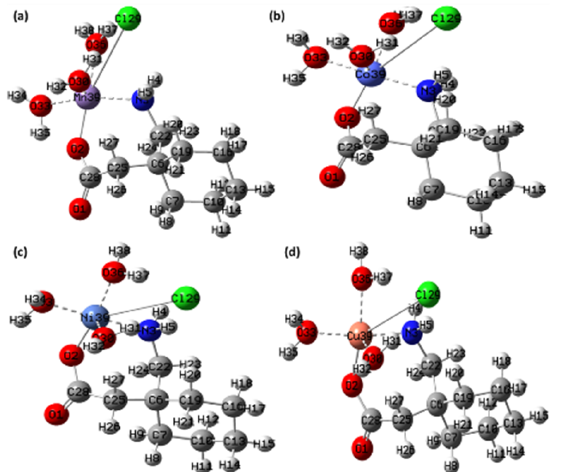
Figure 16. The optimized structure of the synthesized metal complexes ( a ) [Mn(II)–(Gpn)], ( b ) [Co(II)–(Gpn)], ( c ) [Ni(II)–(Gpn)], and ( d ) [Cu(II)–(Gpn)] with the Mulliken atom numbering scheme.